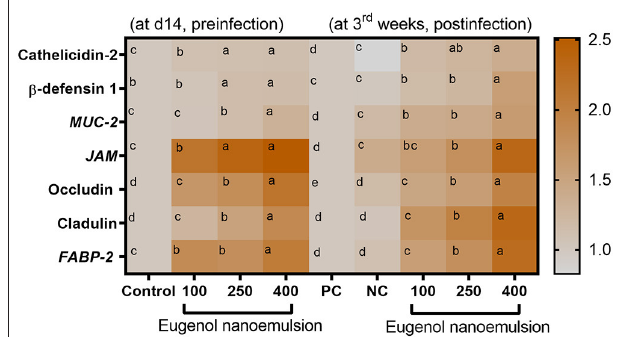
FIGURE 3 | Heat map illustrating the gene expression profiles associated with barrier functions; cathelicidins-2, β -defensin-1, MUC-2 (mucin-2), JAM-2 (junctional adhesion molecule-2), occludin, CLDN-1 (claudins-1), and FABP-2 (fatty acid binding protein-2) in the jejunal tissues of broiler chickens supplemented with different levels of eugenol nanoemulsion pre- (at day 14) and post- (at 3rd week) E. coli O78 challenge determined by RT-qPCR assay. Values are means with their SE. The intensity of orange color denotes the degree of upregulation of the investigated genes. NC (negative control): birds fed basal diet without eugenol nanoemulsion and were not challenged, PC (positive control): birds fed a control diet without eugenol nanoemulsion and were challenged, eugenol nanoemulsion 100, 250, and 400: birds fed basal diet supplemented with 100, 250, and 400 mg/kg diet eugenol nanoemulsion. All groups except NC were challenged with E. coli O78 at 14 days of age. Different letters within the same row indicate a statistical significance ( P <